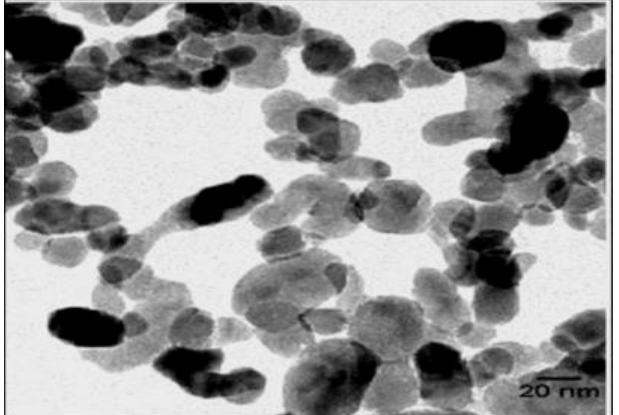
Figure 2. TEM image of zinc oxide NPs.